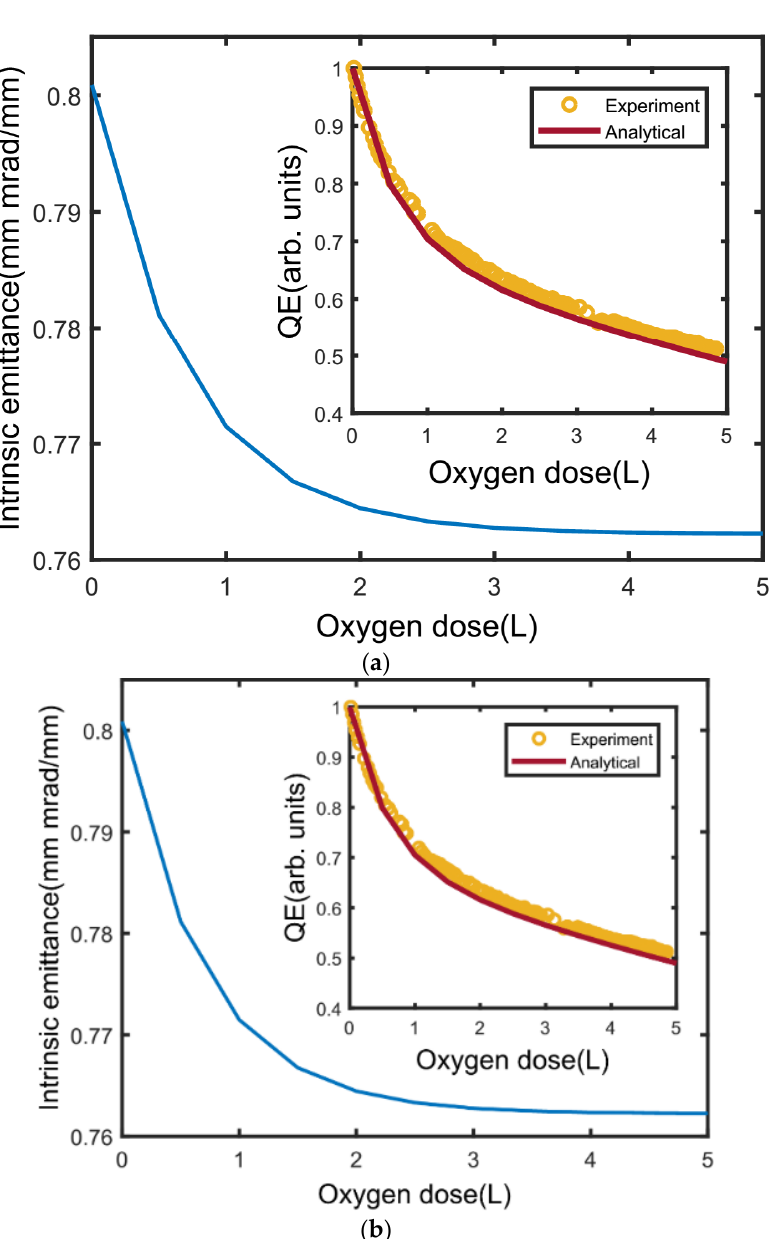
Figure 15. ( a ) Experimental and analytical model of QE’s decay along with oxygen dose in the chamber; ( b ) QE and intrinsic emittance evolution of Cs 3 Sb photocathode with incident photon energy at 1.8 and 1.9 eV, respectively [66] .